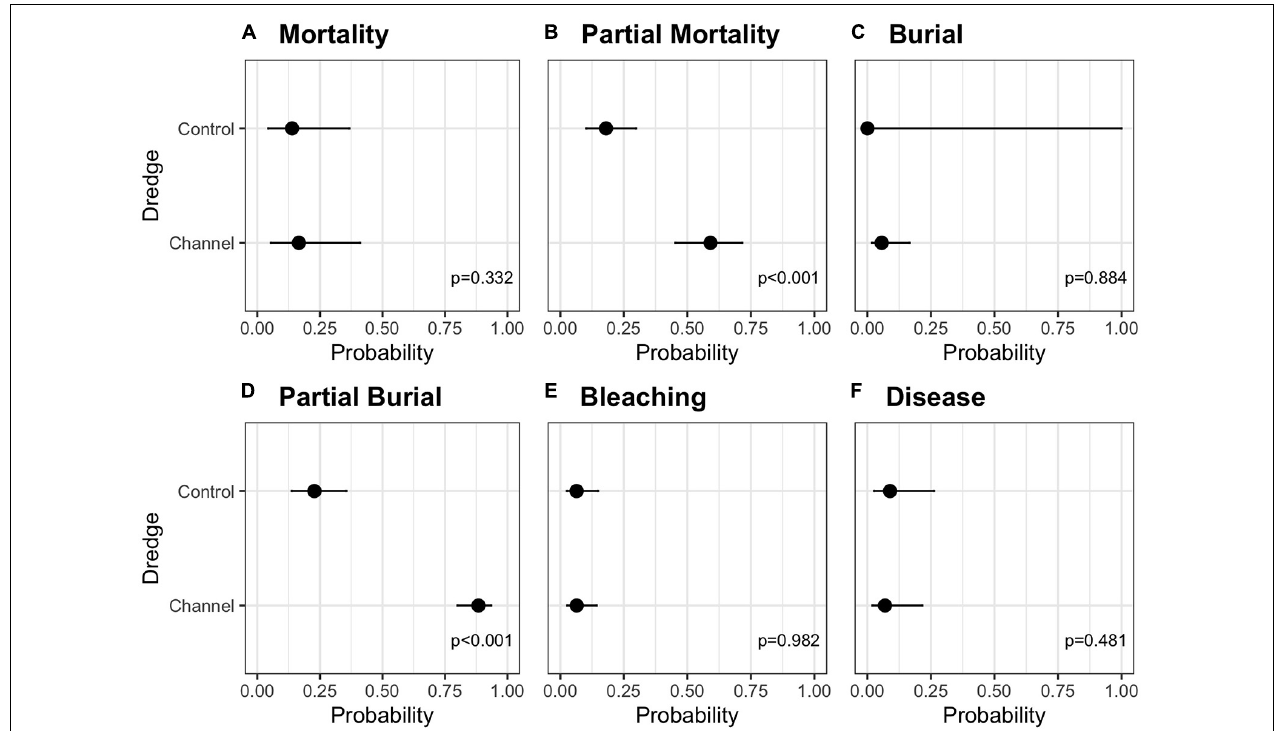
FIGURE 3 | Estimated marginal means (emmeans) post-hoc analysis comparing the probability of (A) mortality, (B) partial mortality, (C) burial, (D) partial burial, (E) bleaching, or (F) disease based on a coral’s location to the dredge (control vs. channel site) with the upper and lower 95% confidence intervals. Analyses are for the full 615 tagged coral data